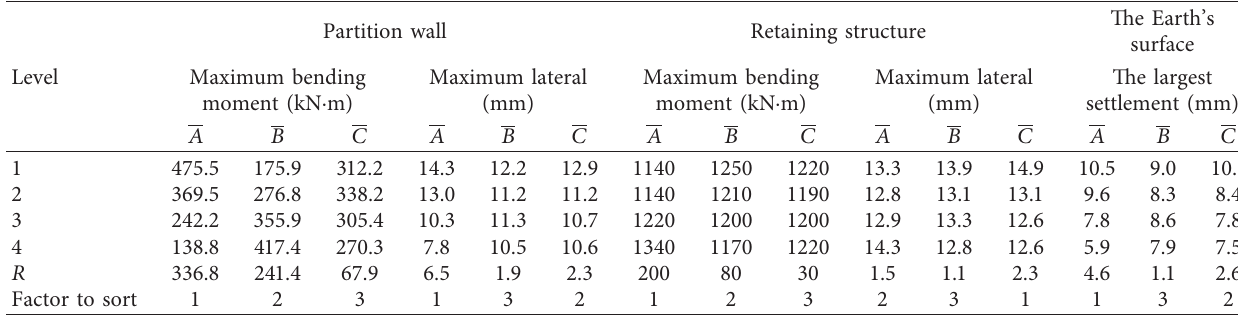
Table 8: Average of the different levels for each